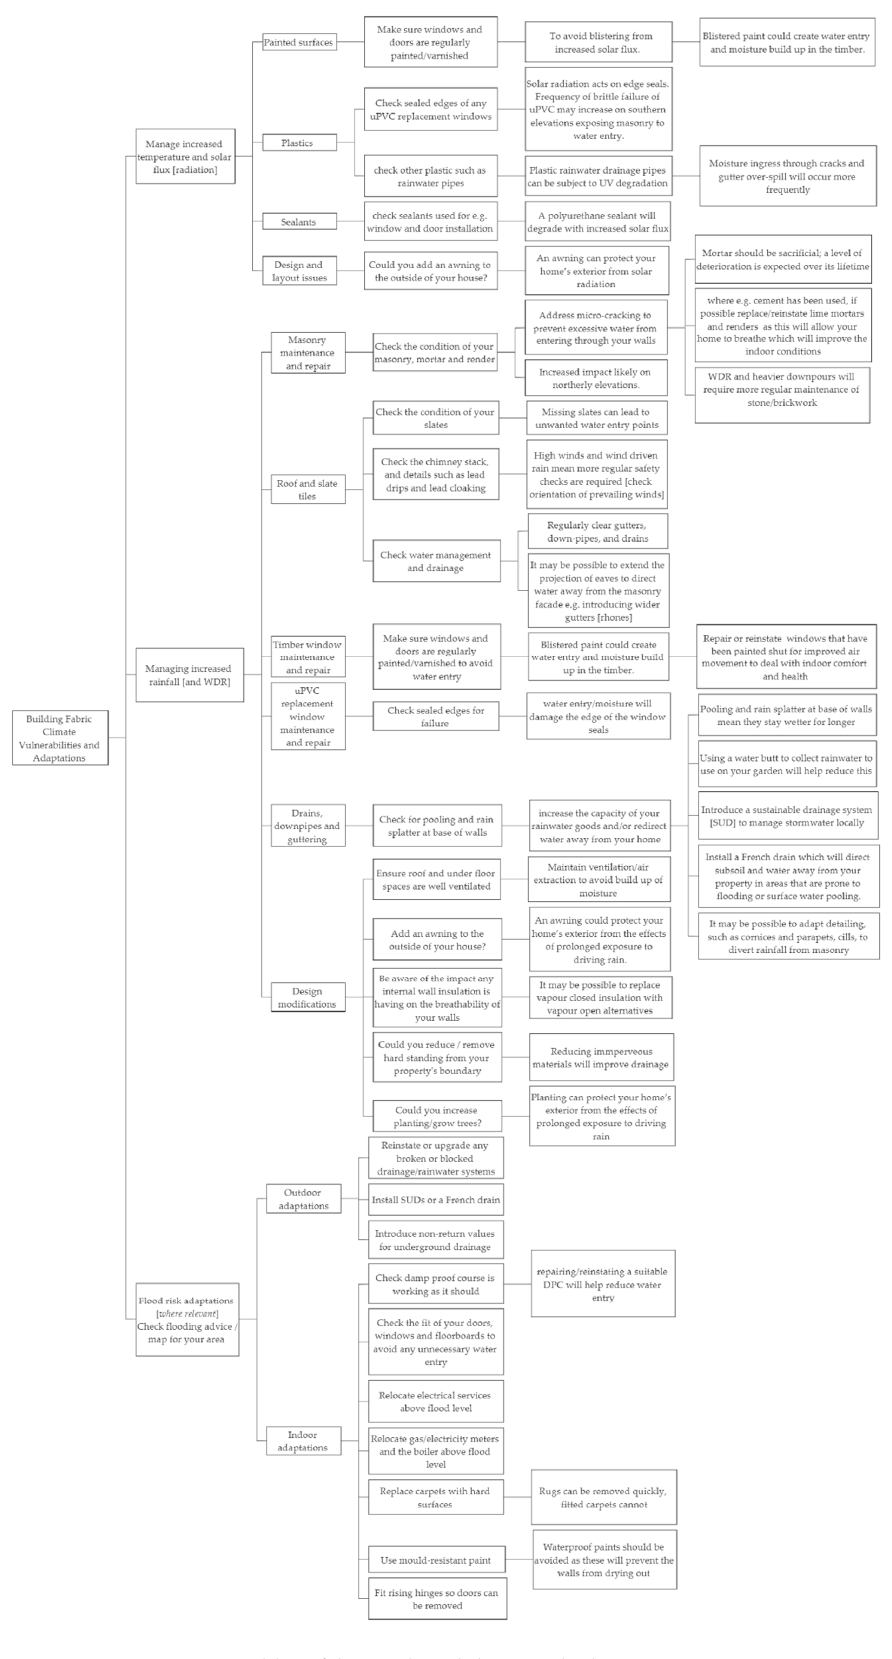
Figure 11. Building fabric vulnerabilities and